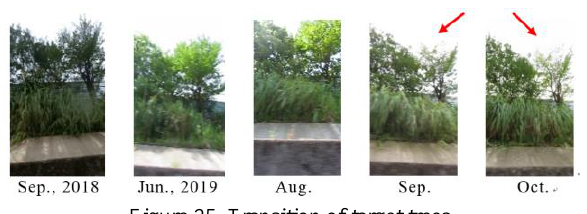
Figure 25. Transition of target trees